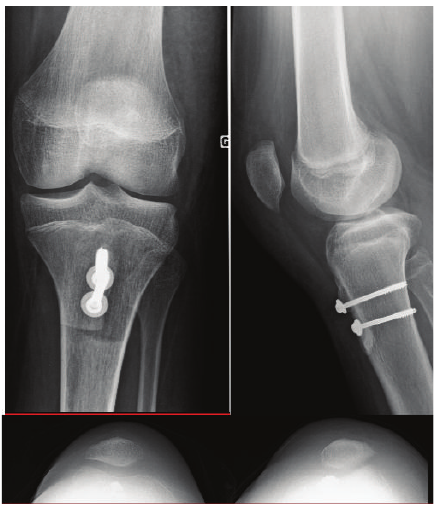
Figure 2: Postoperative radiograph of the knee after medial tibial tubercle transfer and vastus medialis plasty. The patella is better centred.